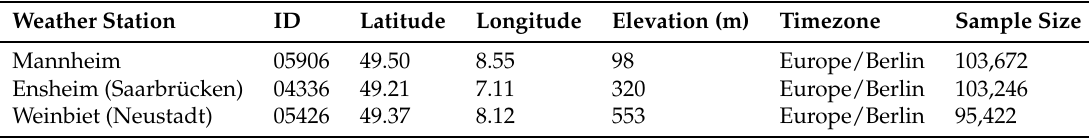
Table 2. Deutscher Wetterdienst (DWD) weather stations in Germany and their locations. Weather